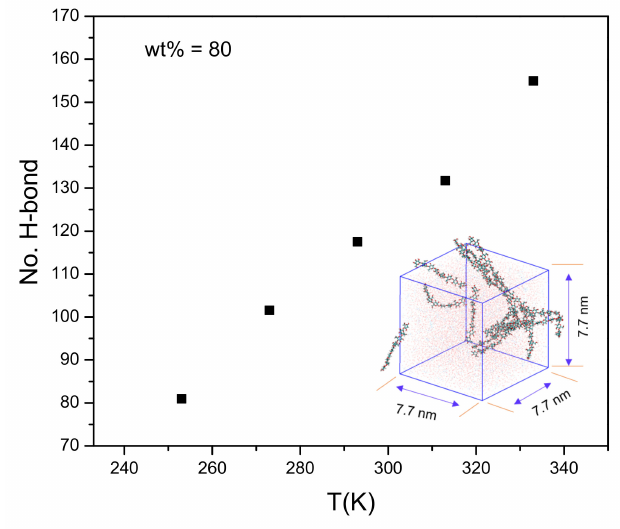
Figure 4. The (50–100 ns) average number of H-bonds between cellulose chains and ILs in different temperatures (80 wt%